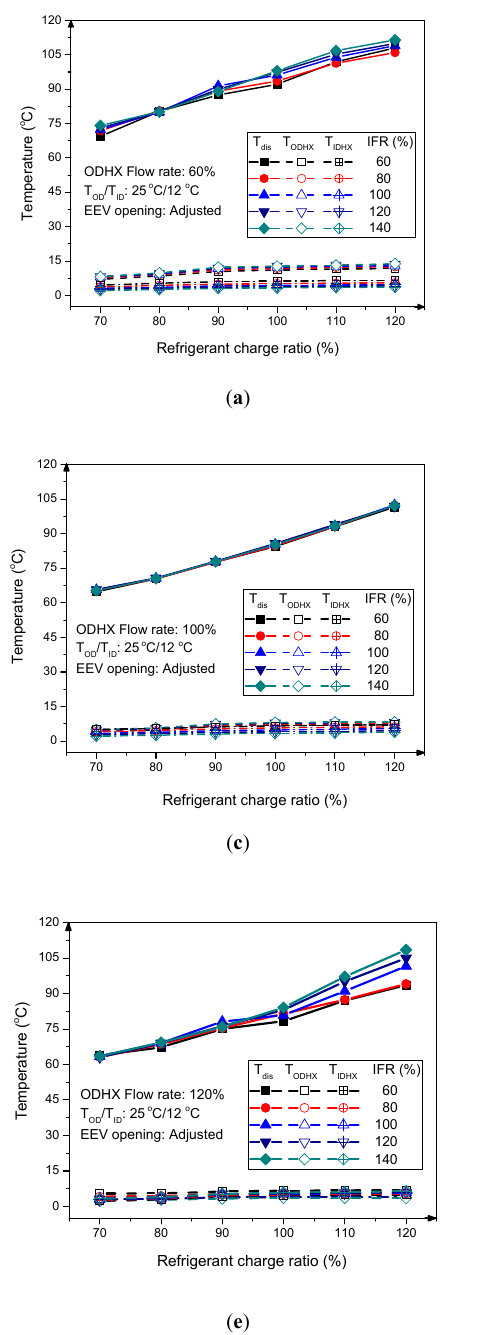
Figure 10. Variation of compressor discharge temperature, temperature difference of outdoor heat exchanger secondary fluid, temperature difference of indoor heat exchanger secondary fluid according to refrigerant charge ratio and indoor heat exchanger secondary fluid flow rate of ( a ) 60%, ( b ) 80%, ( c ) 100%, ( d )120% and ( e ) 140%.